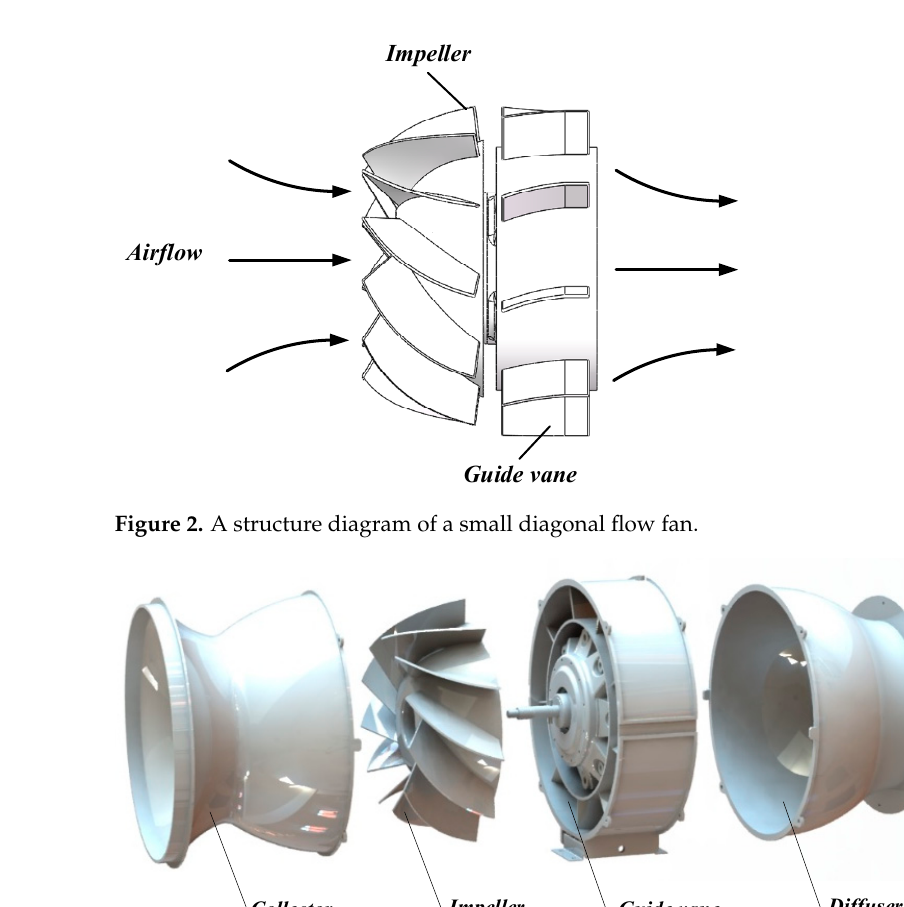
Figure 3. A structure diagram of each component.